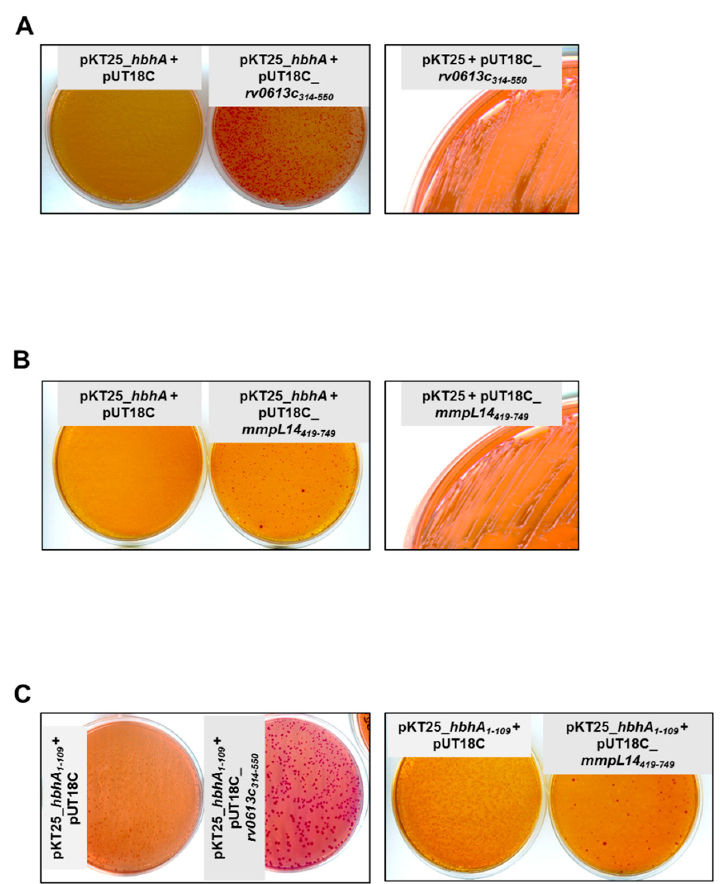
Figure 1. HBHA interacts with Rv0613c and MmpL14 in the BACTH system. ( A ) Red